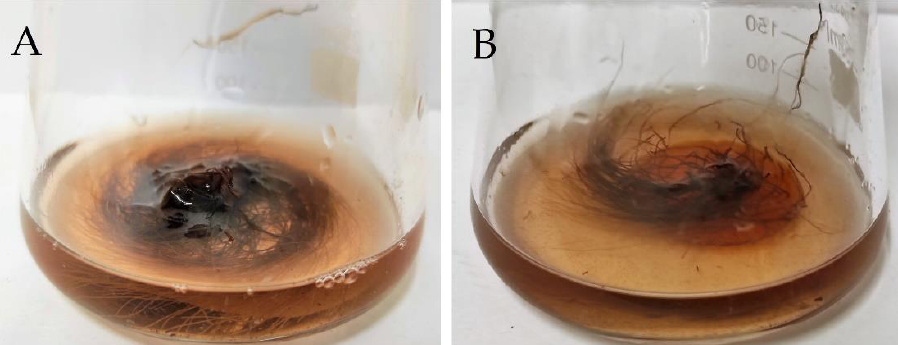
Figure 5. Morphology of R. graeca hairy roots immobilized on investigated organic-ester-based constructs: ( A ) hairy roots elevated to the gaseous phase by PLA scaffold, and ( B ) hairy roots fully submerged inside the liquid phase on PGS scaffold (after 28 days of in vitro culture).